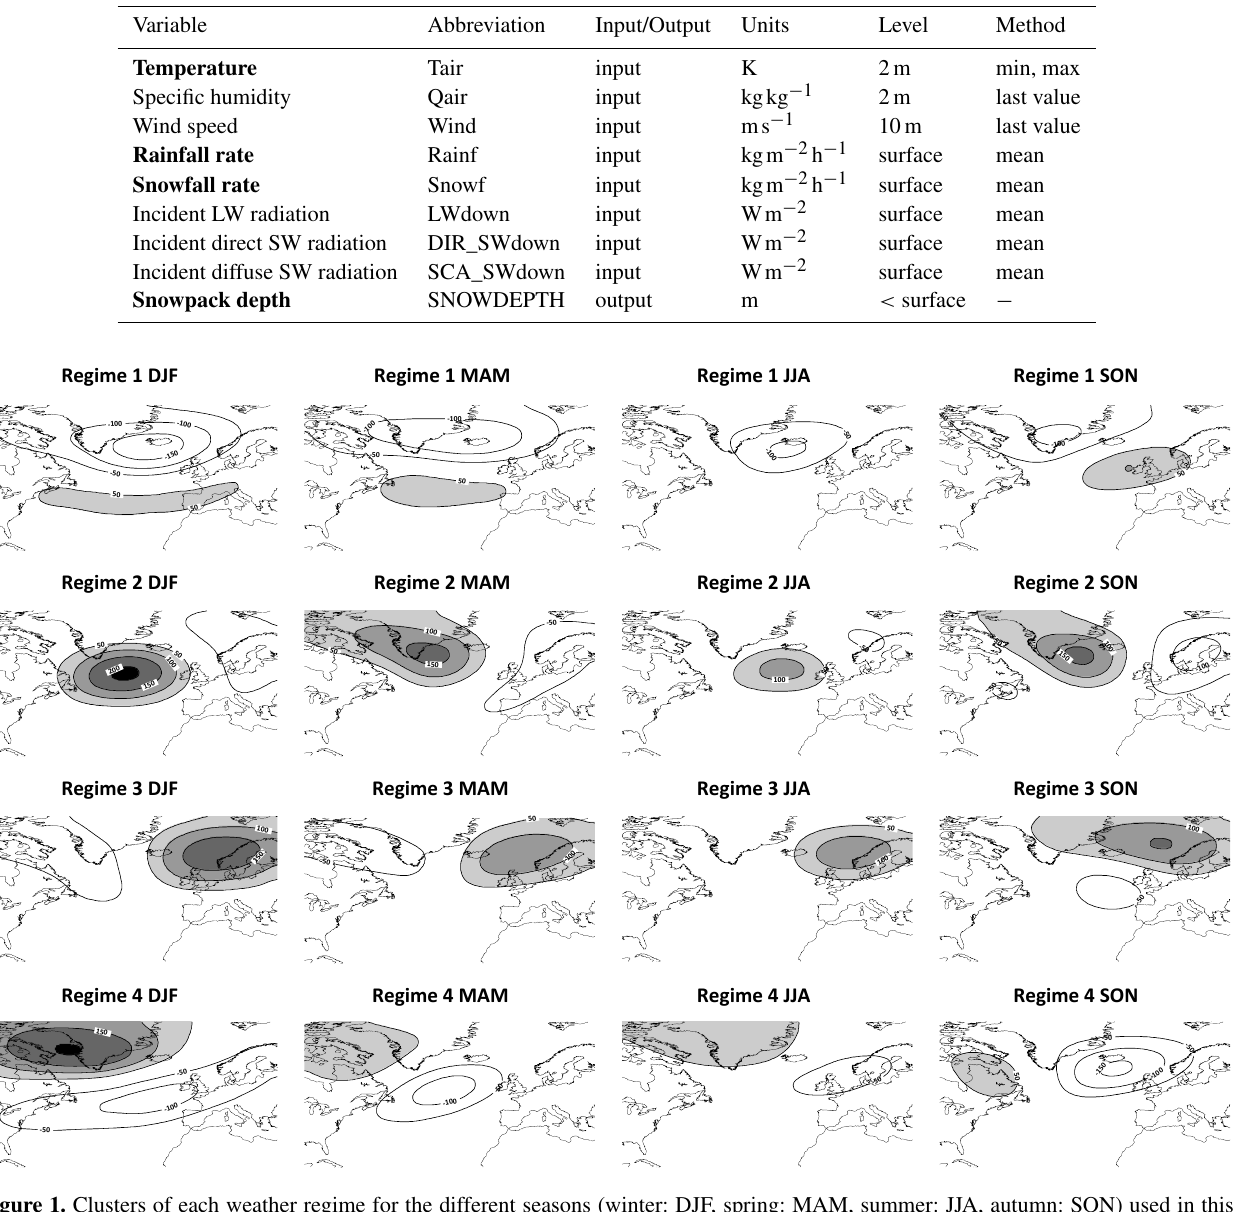
taking into account the season and the weather